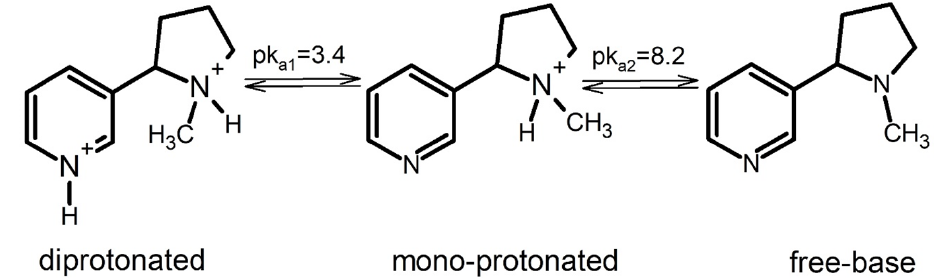
Figure 1. Nicotine forms.